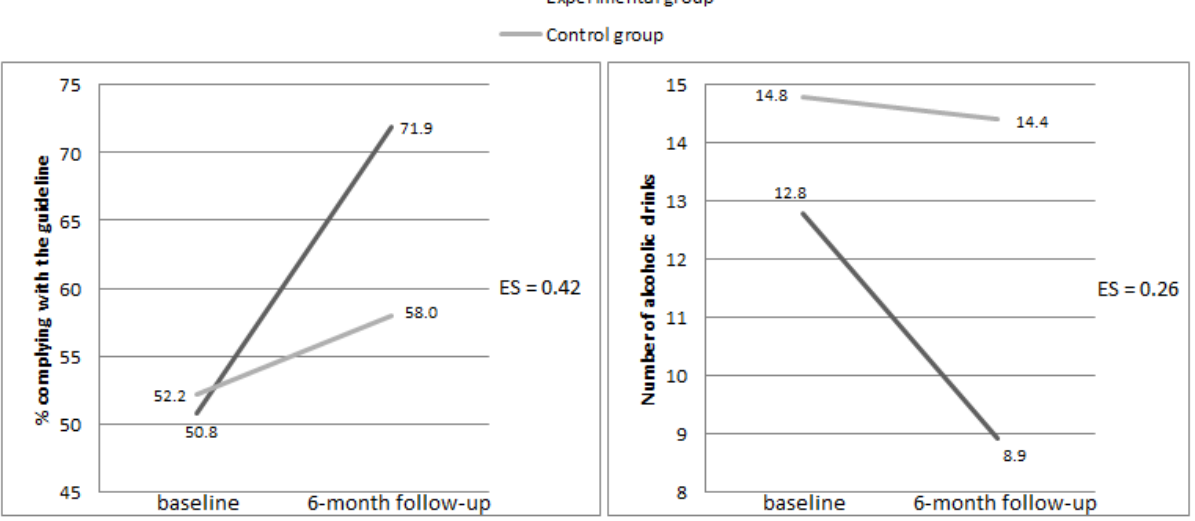
Figure 3. Differences and effect sizes (ES) regarding compliance with the alcohol guideline among complete cases (n=197) and number of alcoholic drinks per week between the experimental group and the control group at baseline and after 6